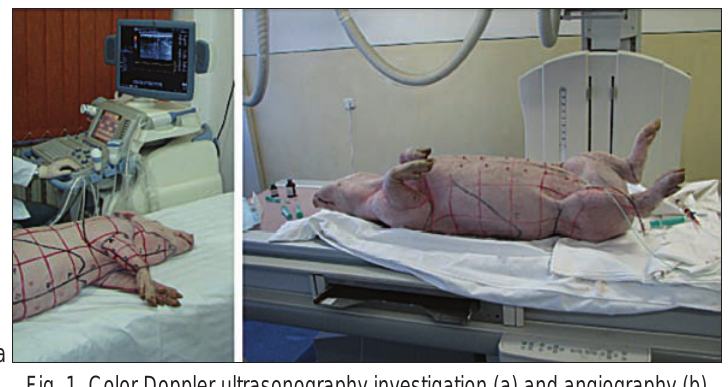
Fig. 1. Color Doppler ultrasonography investigation (a) and angiography (b)